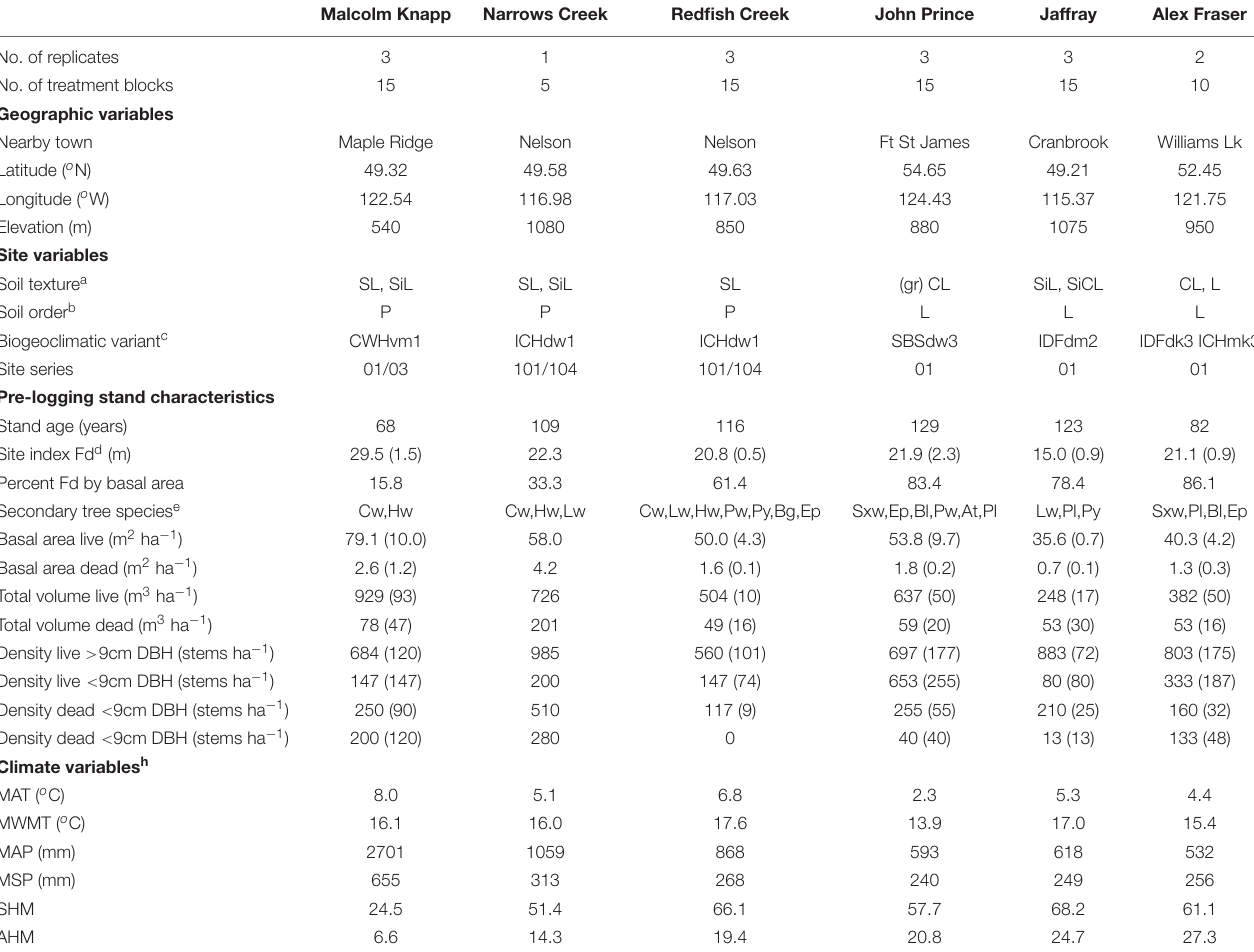
TABLE 1 | Characteristics of the six study locations In British Columbia, Canada ( n = 3 for all locations, except Narrows Creek where n = 1, and Alex Fraser where n =